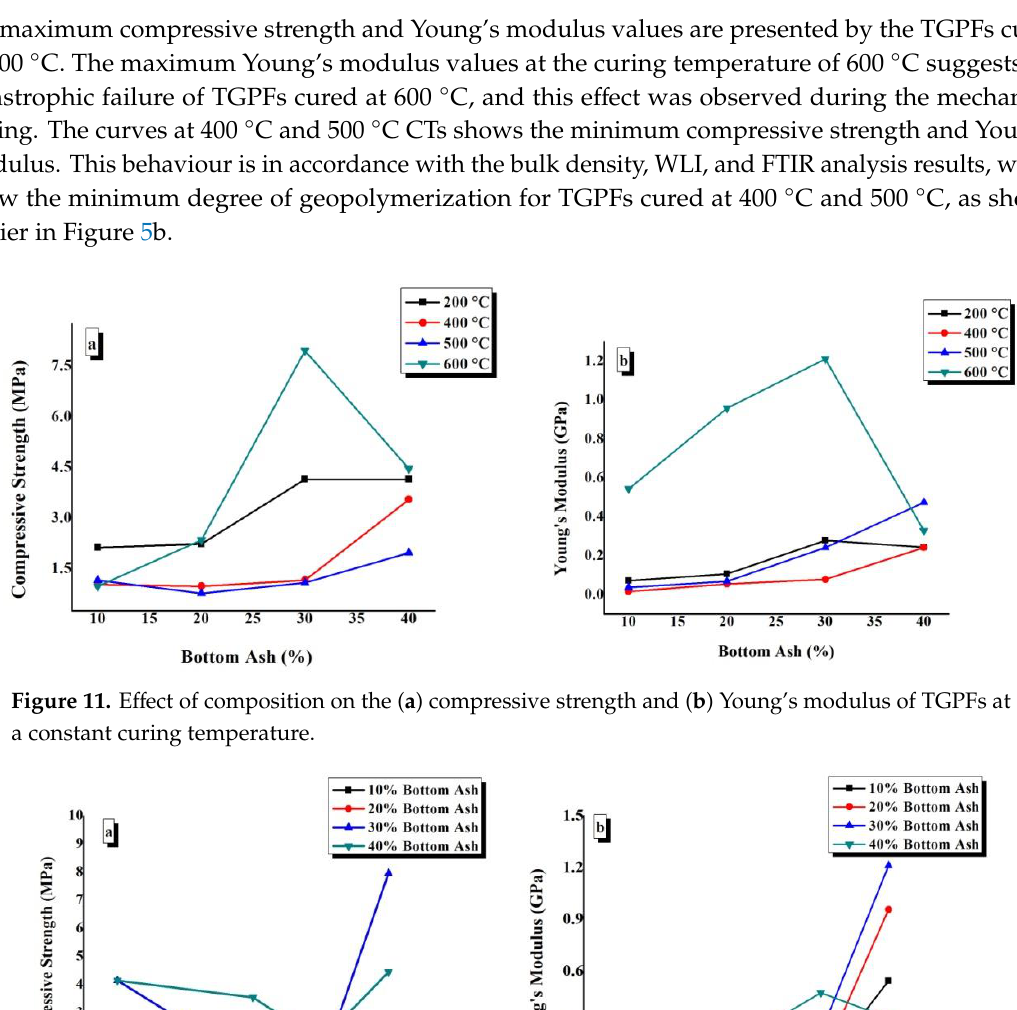
Figure 10. Effect of ( a ) bottom ash content and ( b ) curing temperature on the WLI of TGPFs.